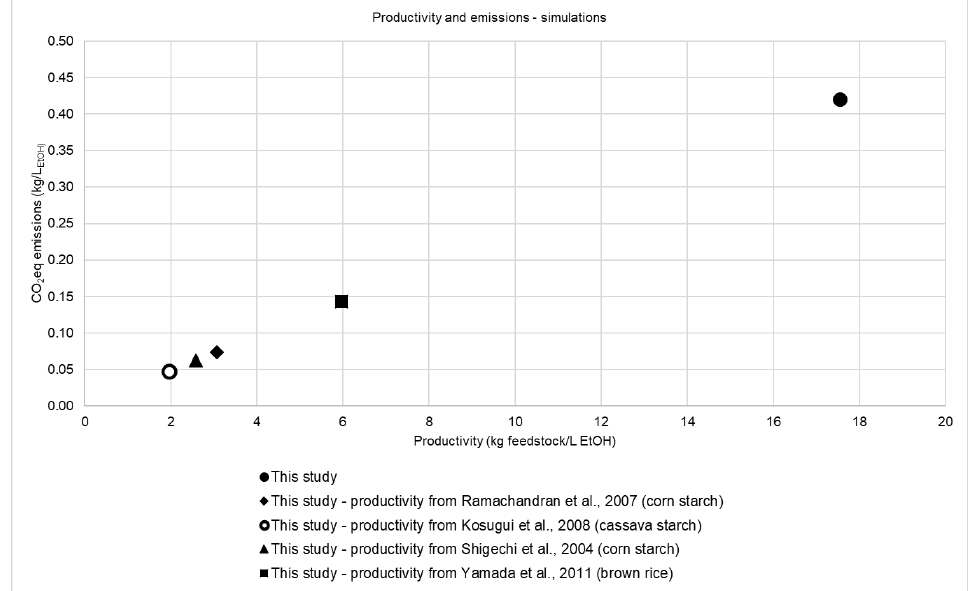
Figure 6. Relationship between productivity and emissions from different simulated scenarios, considering possible genetic modification of yeast strains. Results for the present study only include TRACI values (see Table